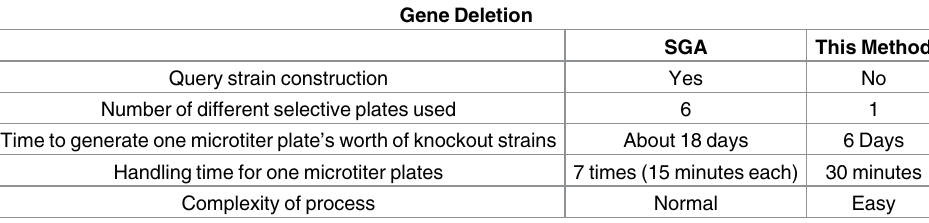
Table 5. Comparison of SGA and high-throughput gene deletion methods. Gene